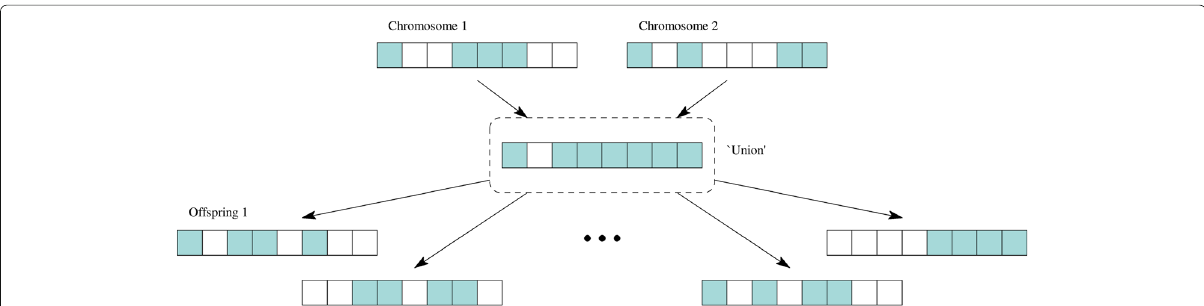
Fig. 1 Pair-wise chromosomal mating as implemented in the proposed genetic algorithm-based sample selection. From a temporary chromosome inheriting all ‘on’ genes from both parents, offspring (children) chromosomes are generated by selecting randomly n r -sized subsets of ‘on’